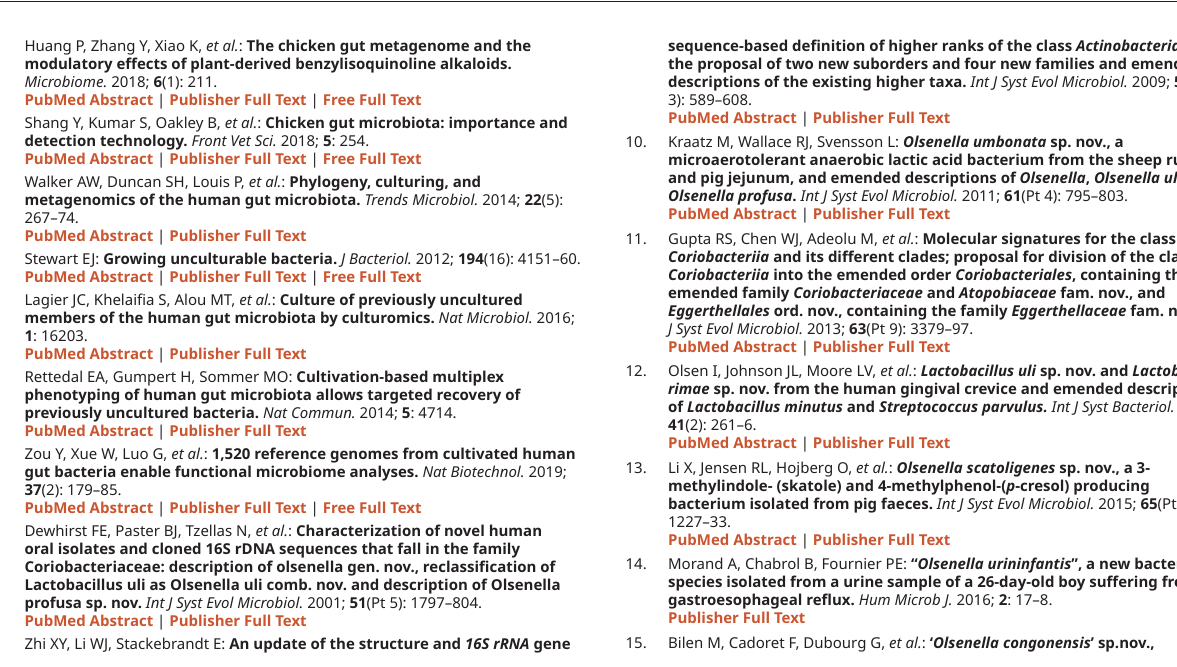
Extended data Figshare: Extended data; Supplemental Table 1 (Functional categories (COGs) from genome of strain SW165 T ), https://doi.